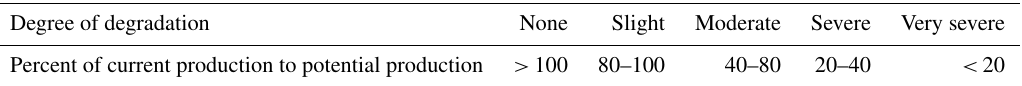
Table 1. FAO–UNEP classification for the current state of degradation (based on percent of current production to potential production). Degree of degradation None Slight Moderate Severe Very severe Percent of current production to potential